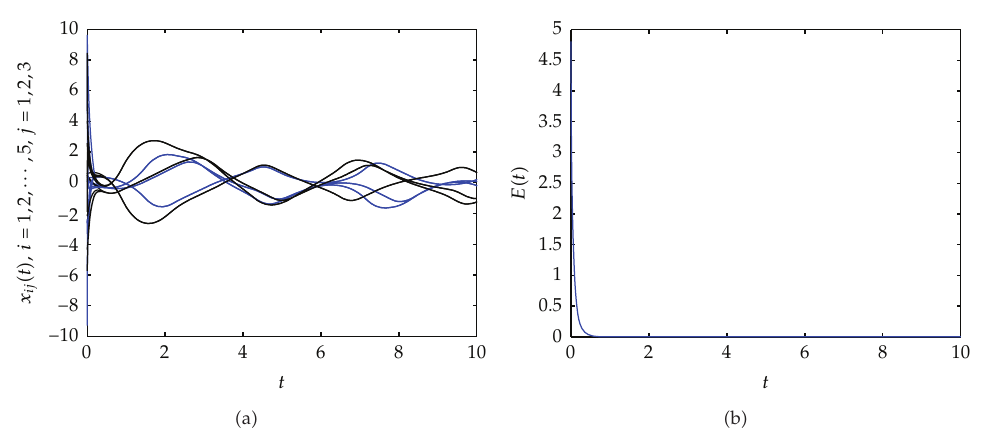
Figure 5: Cluster synchronization of a nonlinearly coupled Hopfield neural network. (cid:6) a (cid:7) The states of the nodes. (cid:6) b (cid:7) The error dynamics of the above Hopfield neural network.